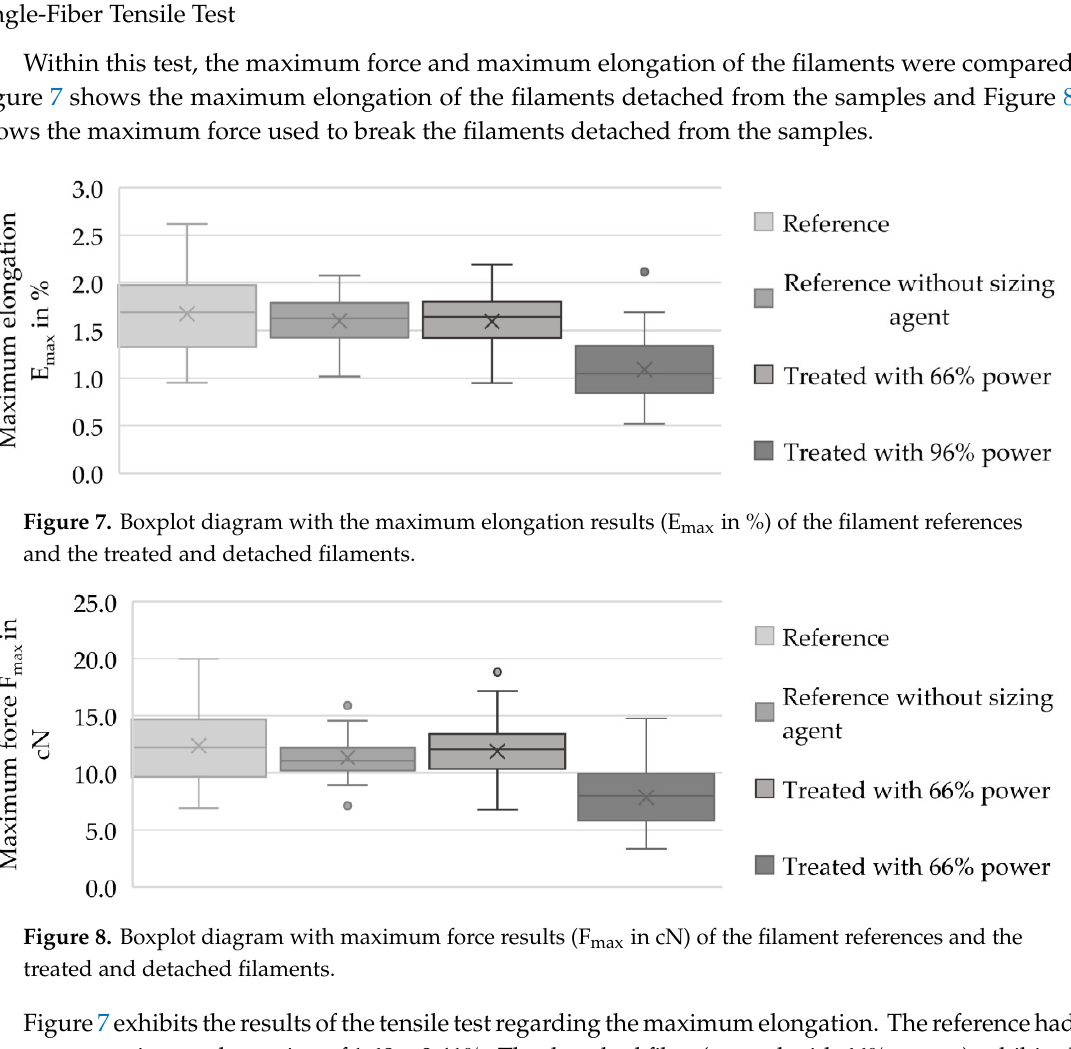
Figure 8. Boxplot diagram with maximum force results (F max in cN) of the filament references and the treated and detached filaments.